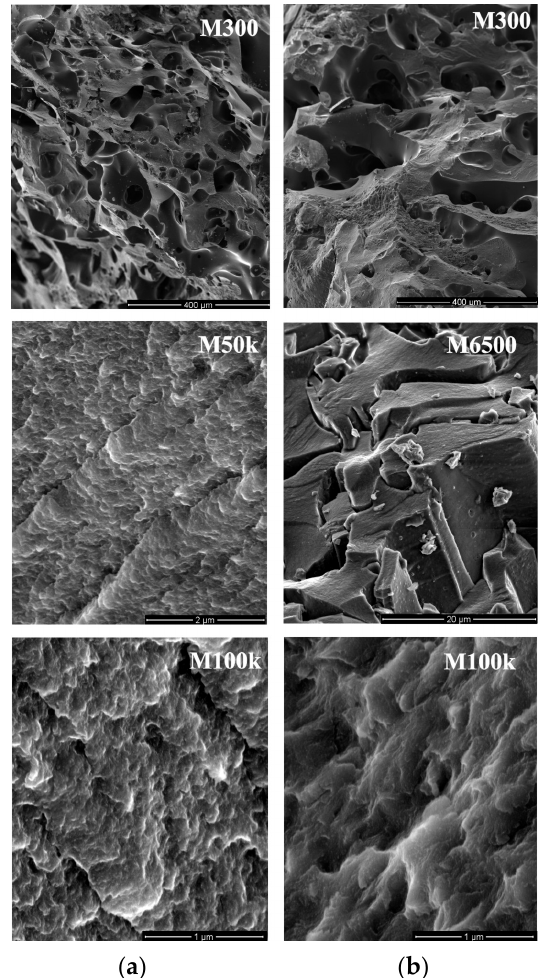
Figure 10. The SEM images of material from compacted zones of plastic layer in charge of fresh ( a ) and thawed ( b ) coals.